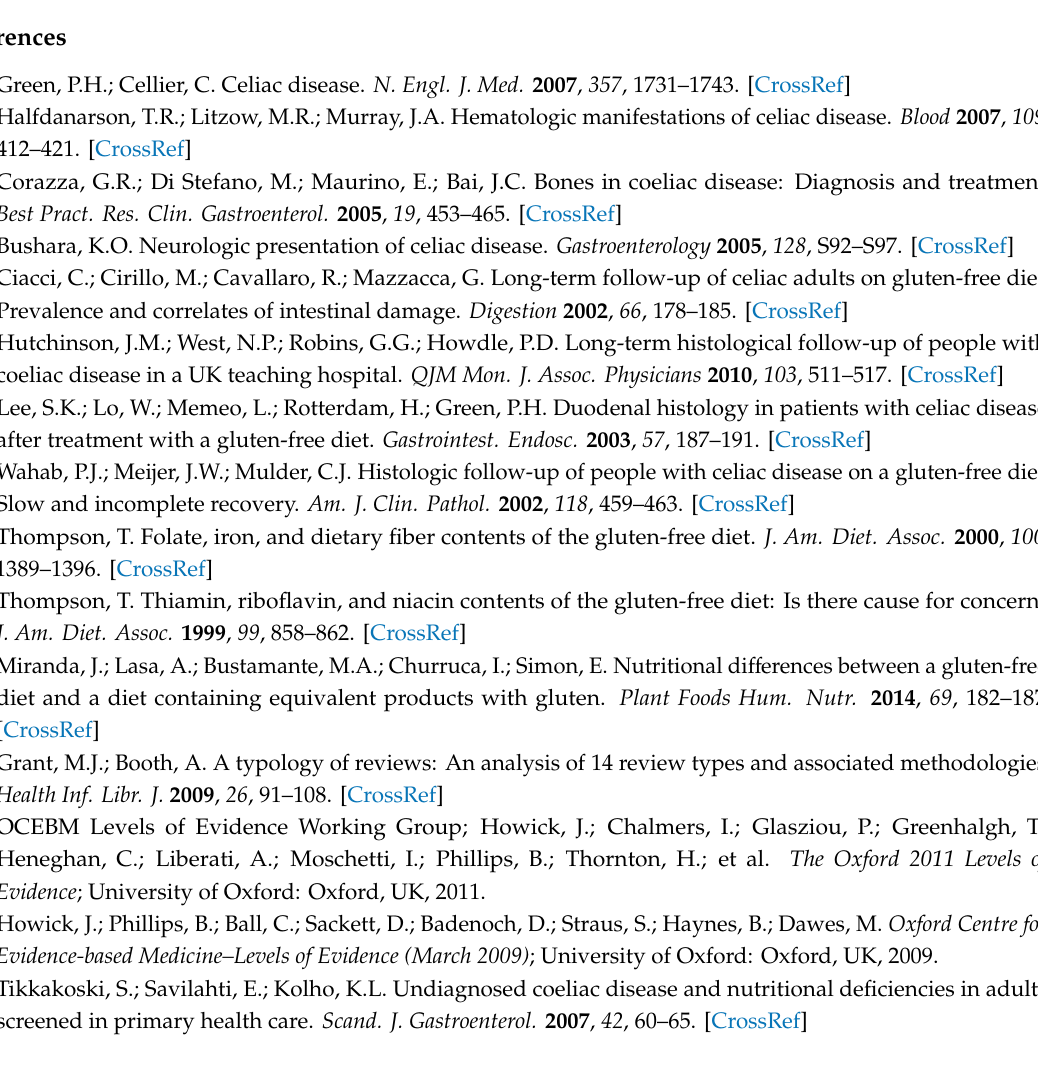
Table S1: Overview of studies included in Tables 1 and 2, describing nutrient deficiencies in celiac disease patients with active and treated CD or nutrient intake in CD patients on a gluten-free